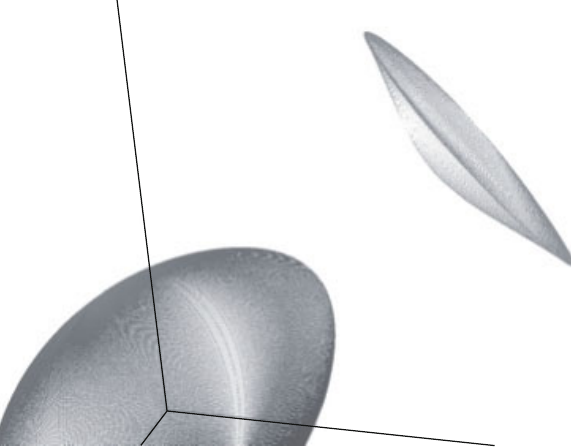
Figure 12: A close view of a portion of the three-dimensional wave front at t = 2 : 4 . The disconnected region displays a circular cusp